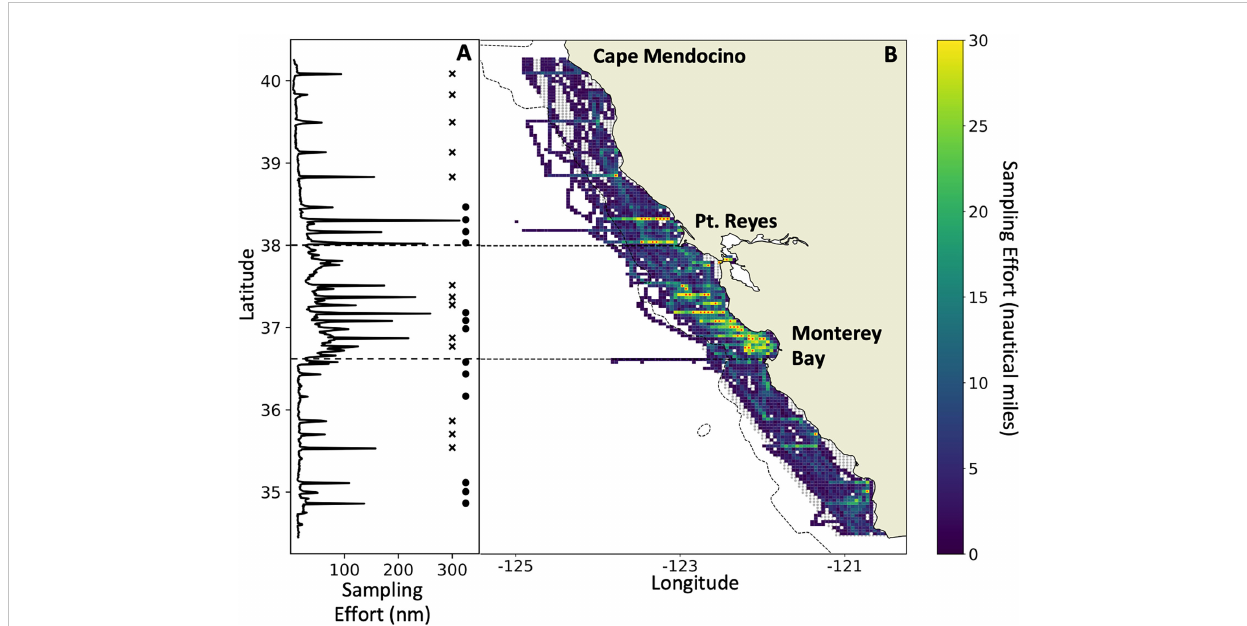
FIGURE 1 Acoustic sampling effort (nautical miles surveyed per grid cell) on the 2012 – 2021 RREAS between Cape Mendocino and Pt. Conception (A) by latitude, and (B) spatially explicit. Horizontal dashed lines delineate the core region de fi ned in the text. Gray shading (in B) represents the spatial extent of the grid (~60 km offshore) used to calculate biomass for the region. Adjacent stars and circles (in A) identify latitudinal transect lines and how they were grouped for analysis. Grid cells with a red marker (in B) exceed the maximum number of nautical miles set by the color scale. The maximum number of nautical miles sampled in any grid cell was 88.5